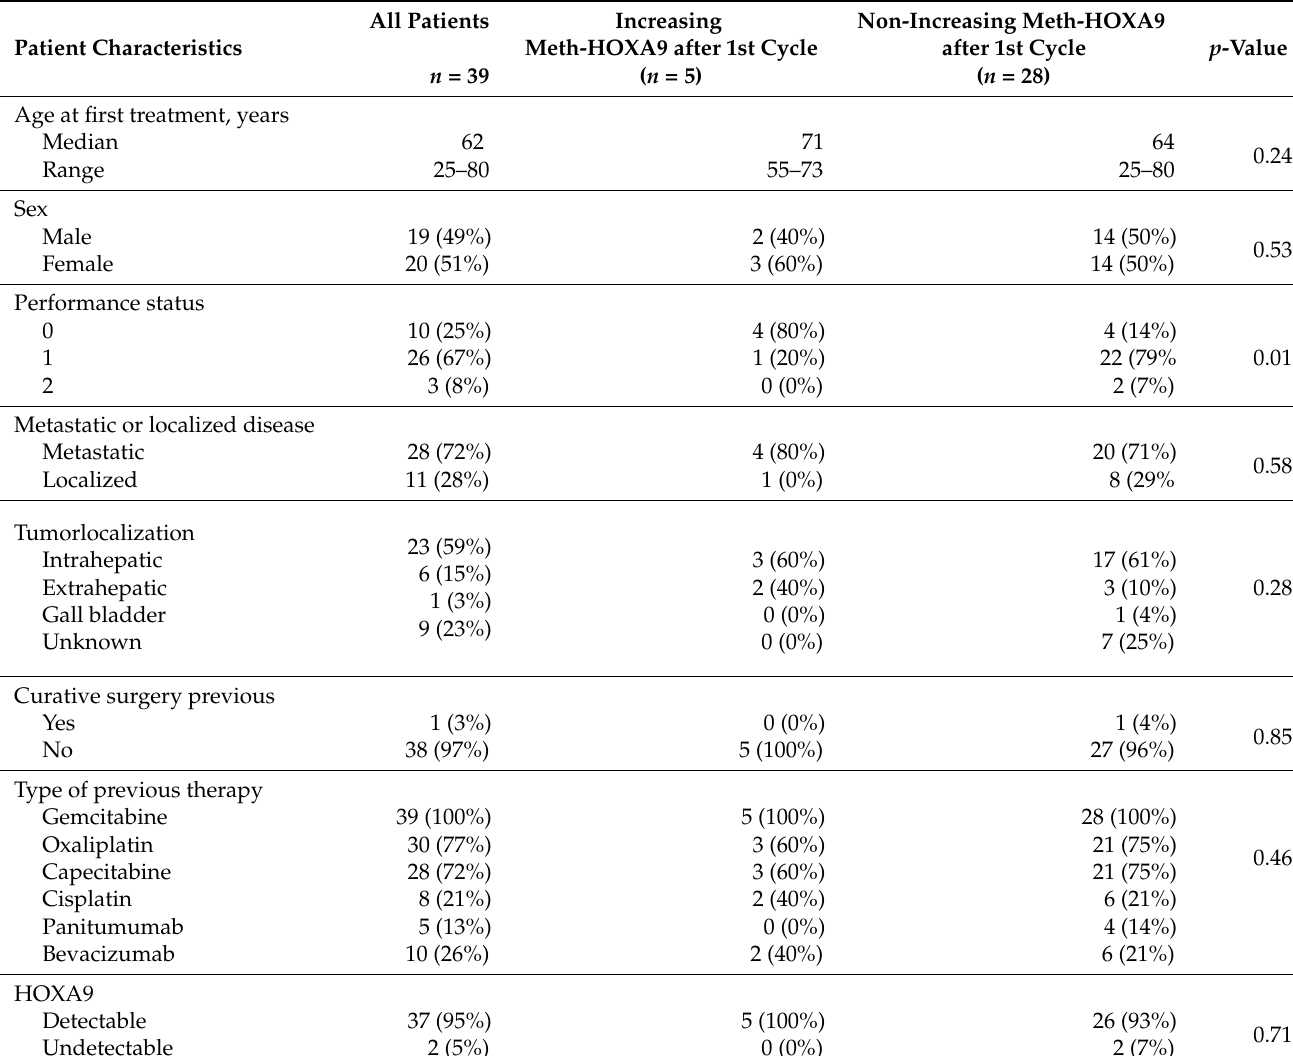
Table 1. Patient Characteristics and Dynamics of Meth-HOXA9 ( n = 39).